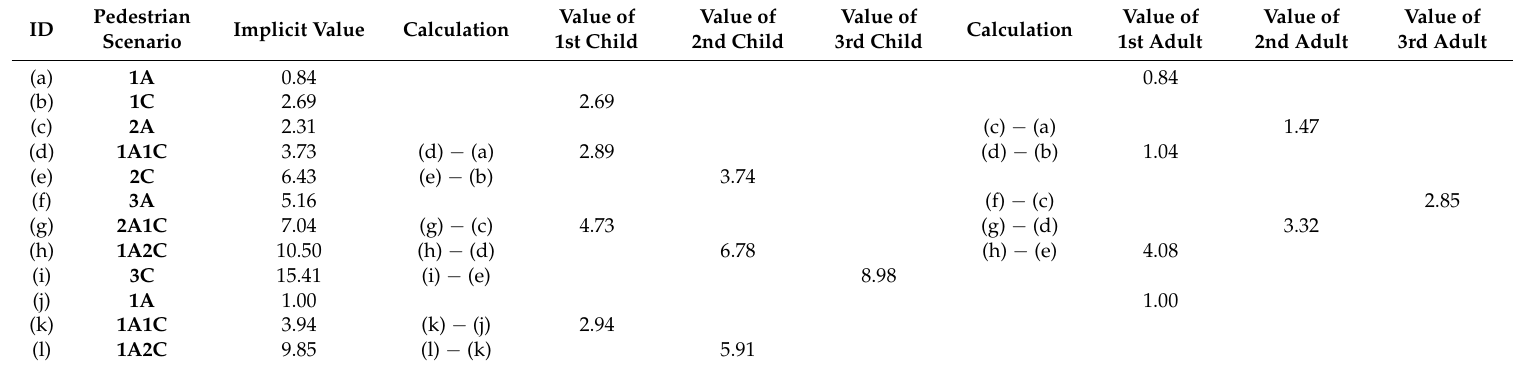
Table 5. Calculated implicit value by